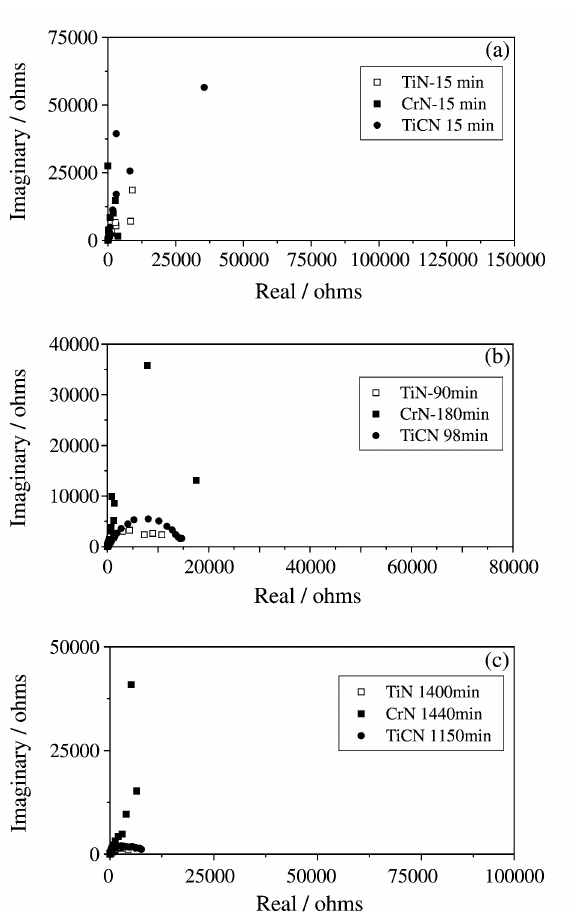
Figure 3. Comparative electrochemical behavior of the TiN, CrN and TiC x N y coatings: (a) Exposition time = 15 min; (b) Exposition time = 90